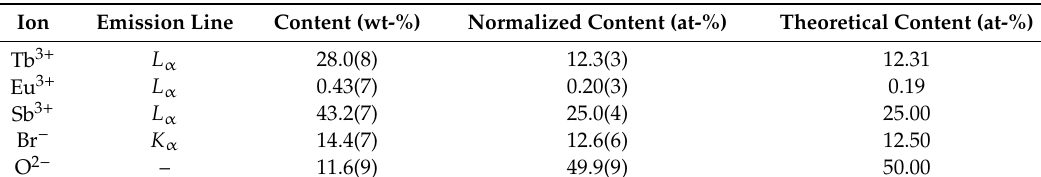
using wavelength-dispersive spectrometry and the Pouchou and Pichoir (PaP) matrix correction algorithm. The oxygen content was calculated stoichiometrically.